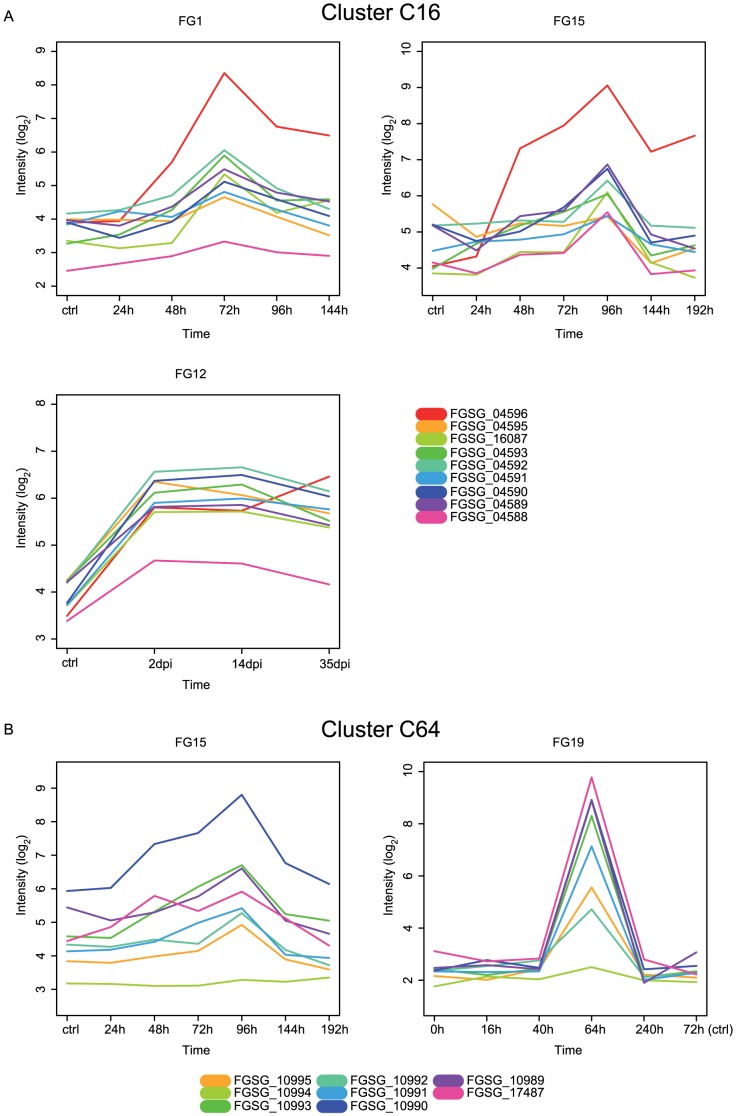
Expression profiles of gene cluster C16 and C64 during in planta time series experiments.Expression profiles of gene cluster C16 and C64. Time points are depicted on x-axis, y-axis shows log2 intensity of gene expression. (A) Expression profile of cluster C16 during barley (FG1) and wheat infection (FG12, FG15). (B) Gene expression during wheat infection (FG15, FG19) of cluster C64.